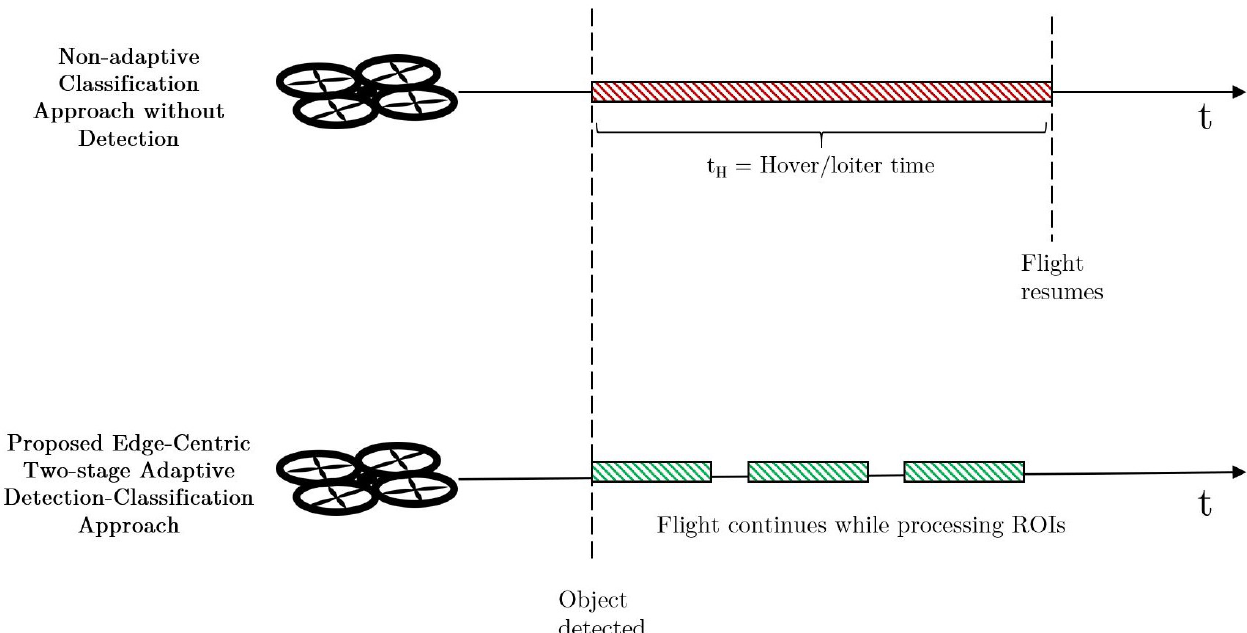
Figure 10. Flight time